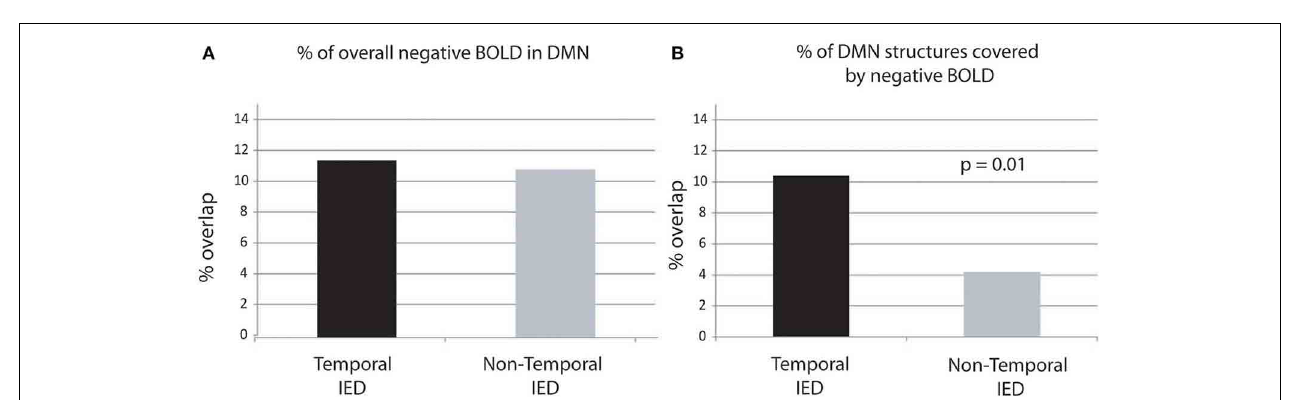
FIGURE 4 | Percentage of overlap between negative BOLD and DMN structures. The percentage of DMN structures covered by negative BOLD is significantly higher in temporal than extra-temporal